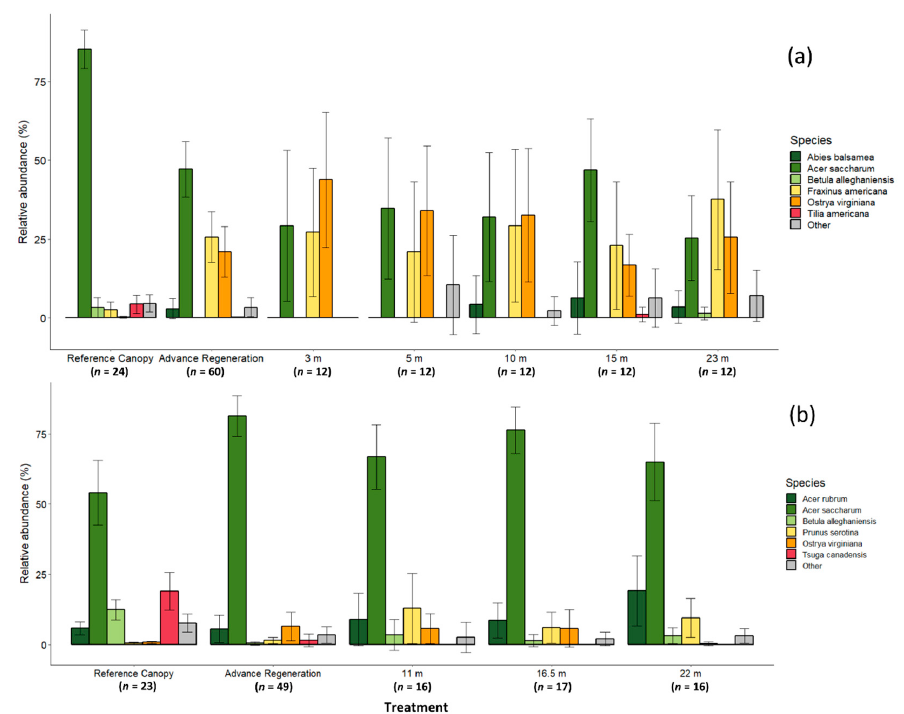
Figure 1. The relative abundance of major species in two group-selection study sites in northern hardwood forests of the upper Great Lakes, USA: ( a ) Divide Canopy Gap Study (DCGS); ( b ) Yellow Birch Legacy Project (YBLP). Reference canopies were measured in fixed-radius plots near experimental openingsintheyearpriortoharvestineachrespectivestudy. Advanceregenerationswereapproximated as saplings remaining 2-years post-harvest, > 0.5 m height in the YBLP and > 0.6 m height in the DCGS. Composition of gap-capturing saplings described in experimental group-selection openings was measured at 15 years post-harvest in the YBLP and 23 years post-harvest in the DCGS. Error bars represent 95% confidence intervals. MRPP species compositional groupings are shown in Table